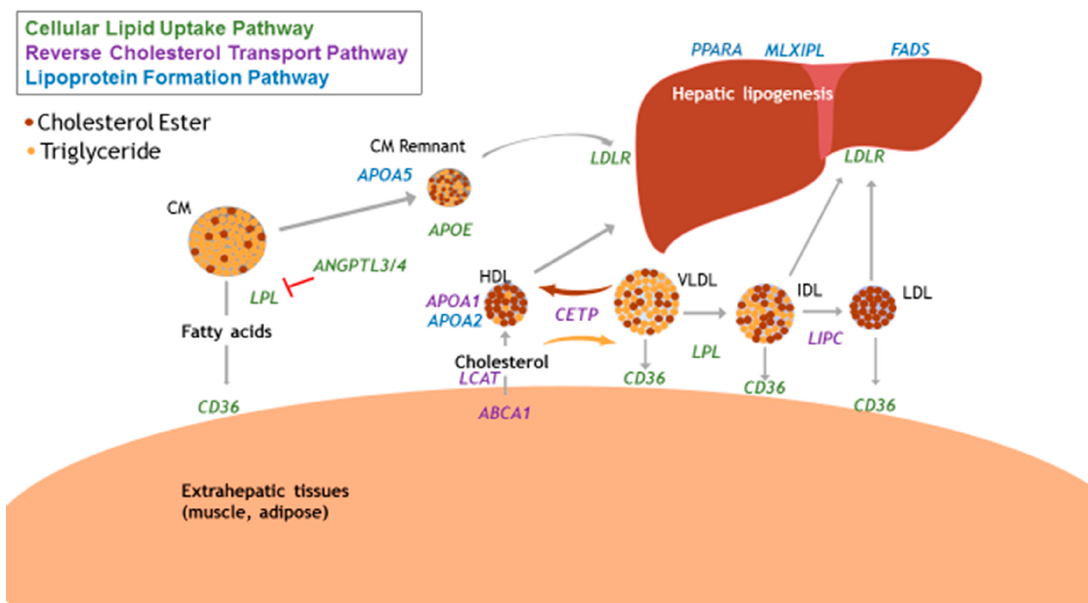
Figure 2. Physiologically relevant genes of lipid and lipoprotein metabolism pathways. CM, chylomicron; HDL, high-density lipoprotein; IDL, intermediate density lipoprotein; LDL, low-density lipoprotein; VLDL, very-low density lipoprotein; ABCA1 , ATP-binding cassette transported subfamily A member 1; ANGPTL3/4 , angiopoietin-like proteins 3 & 4; APOA1, apolipoprotein AI; APOA2, apolipoprotein AII; APOAV, apolipoprotein AV; APOE , apolipoprotein E; CD36 , cluster of differentiation 36 (fatty acid translocase); CETP , cholesterol esterase transfer protein; FADS , fatty acid desaturase cluster; MLXIPL , MLX interacting protein like; LCAT, lecithin, cholesterol acyltransferase; LDLR , LDL receptor; LIPC , hepatic lipase; LPL , lipoprotein lipase; PPARA, peroxisome-proliferator activator receptor alpha;.